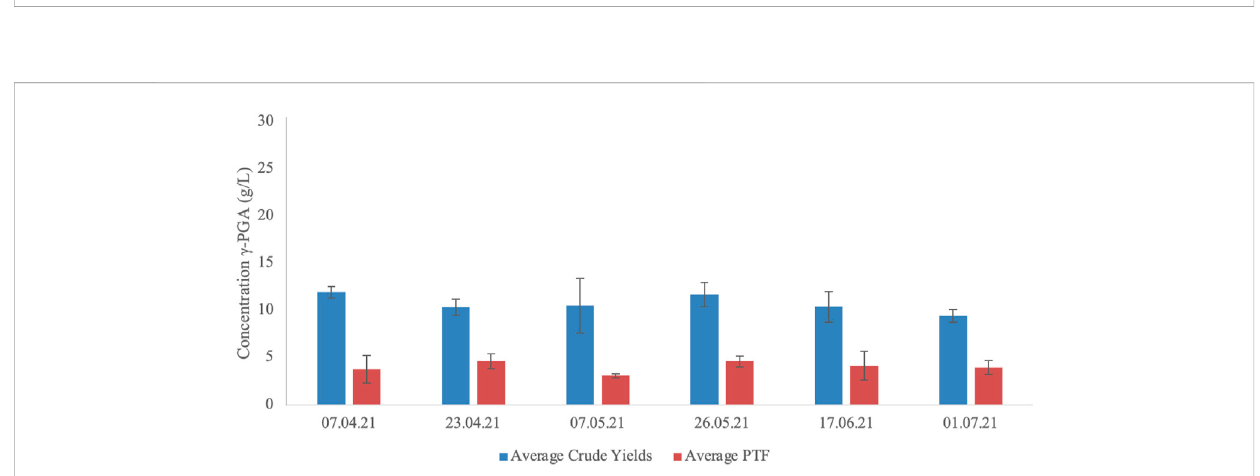
FIGURE 11 Average γ -PGA yields (raw precipitate and PTF) obtained from supplemented Laminaria digitata collected at different points in the year. Error bars indicate standard deviation (n = 3).